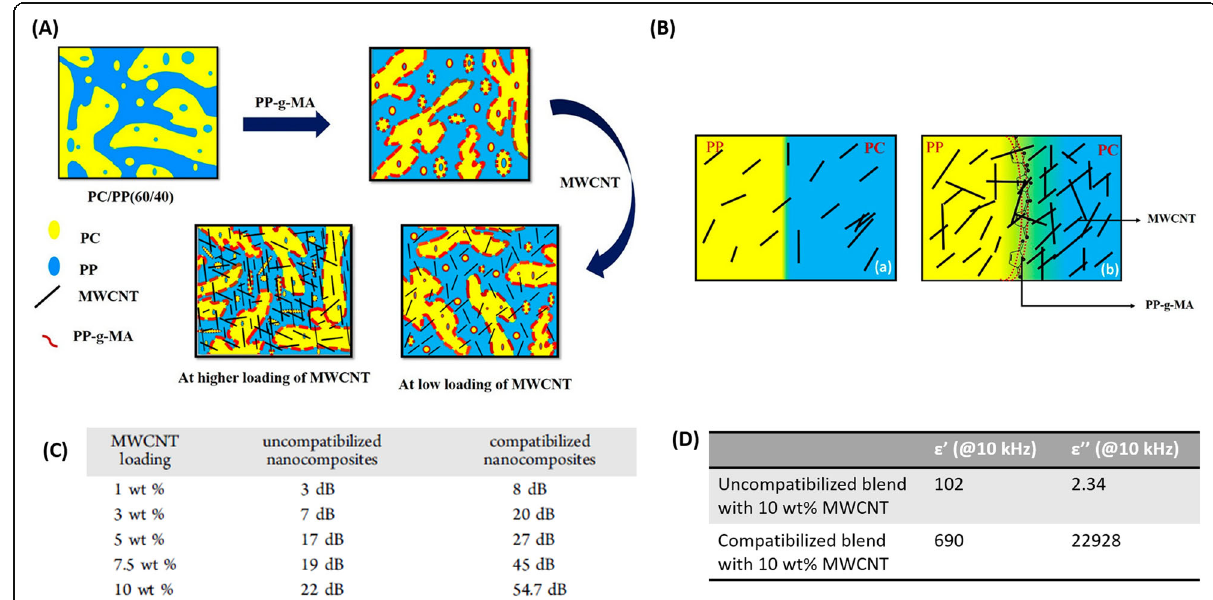
Fig. 17 (A) Schematic representation of the morphological evolution with the incorporation of PP-g-MA and CNT (here labeled as MWCNT); ( B ) Schematic representation of the interface without (left) and with (right) PP-g-MA; ( C ) The table showing the SE T values of uncompatibilized vs. compatibilized blend @3 GHz frequency; ( D ) The table shows the ε ’ and ε ” values of uncompatibilized vs. compatibilized blend with 10